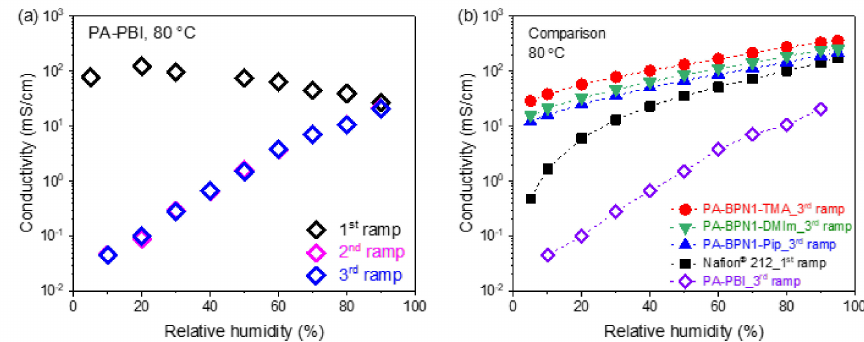
Figure 5. ( a ) Literature reported proton conductivity data of phosphoric acid-doped polybenzimidazole (PA-PBI) under successive RH ramps at 80 ◦ C [24]; and ( b ) comparison of proton conductivities of